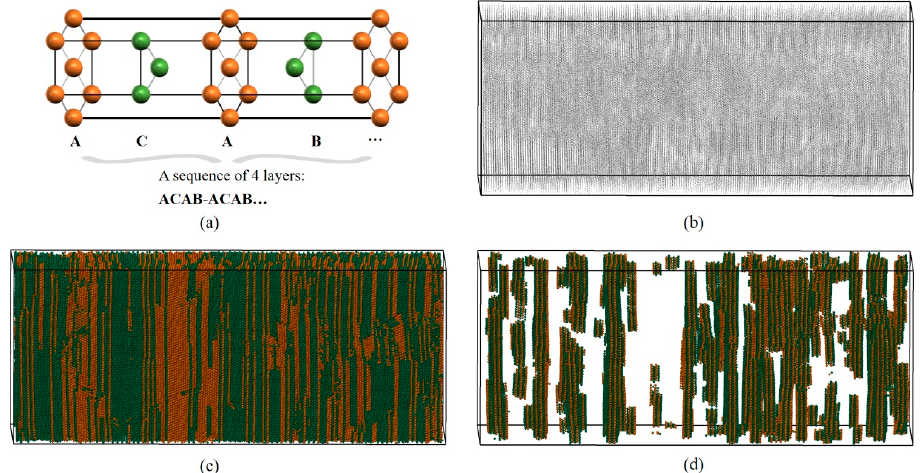
Figure 3. Schematic diagram of DHCP long-range structure analysis of LaSCA. ( a ) Structural feature of the DHCP crystal. ( b ) The FCC and HCP atoms represented by grey points. ( c ) The type-colored FCC and HCP atoms represented by icosahedrons. ( d ) The DHCP atoms in this system.